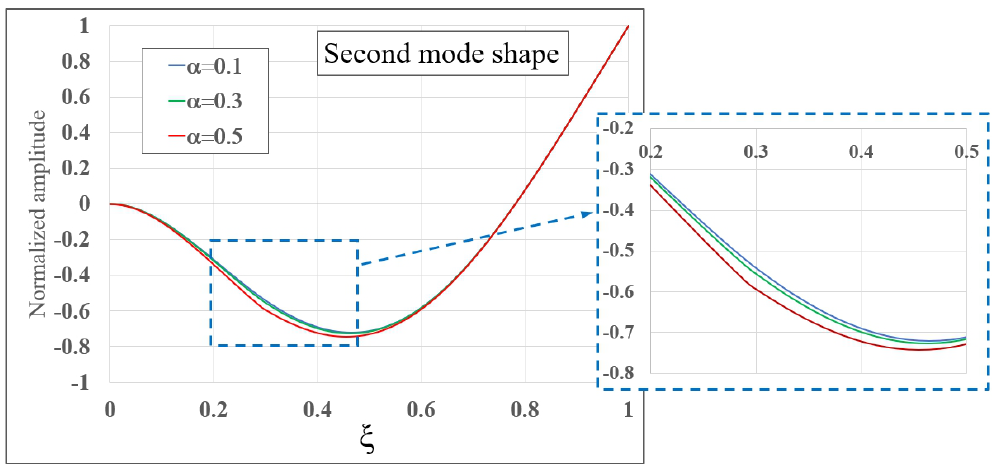
Figure 8. Second mode shape for the case r = 0.2, S L = 120, ξ c = 3, Ω = 6 rad/s and for three different crack depths ( α = 0.1,0.3 and